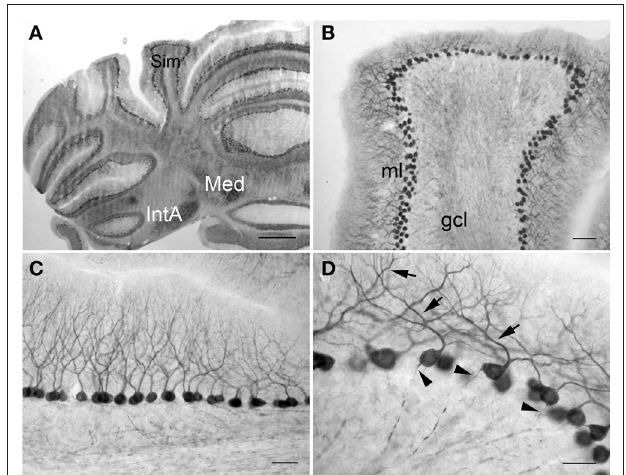
Figure 8 | PlexinA4 in the cerebellum. Micrographs of coronal (A,B) and sagittal (C,D) sections through the adult rat cerebellum stained for PlexinA4. PlexinA4 is present in the Purkinje cell soma, dendrites (arrows in D ) and axons (arrowheads in D ) throughout the cerebellum. Neurons in the medial cerebellar nucleus and anterior interposed cerebellar nucleus also express PlexinA4 (A) . gcl, granule cell layer; IntA, anterior interposed cerebellar nucleus; Med, medial cerebellar nucleus; ml, molecular layer; Sim, simple lobule. Scale bars: (A) 1 mm, (B) 200 μm, (C) 100 μm, (D) 50